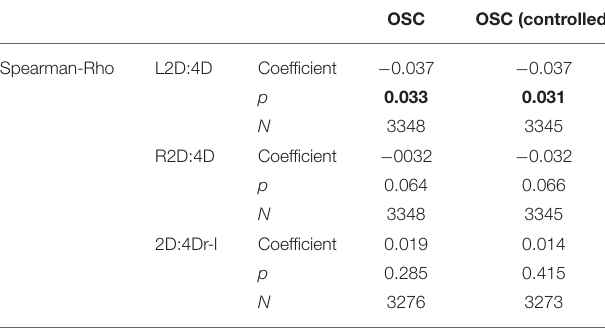
TABLE 1 | Correlation between prenatal testosterone markers and OSC. Spearman-Rho Mean2D:4D Coefficient − 0.042